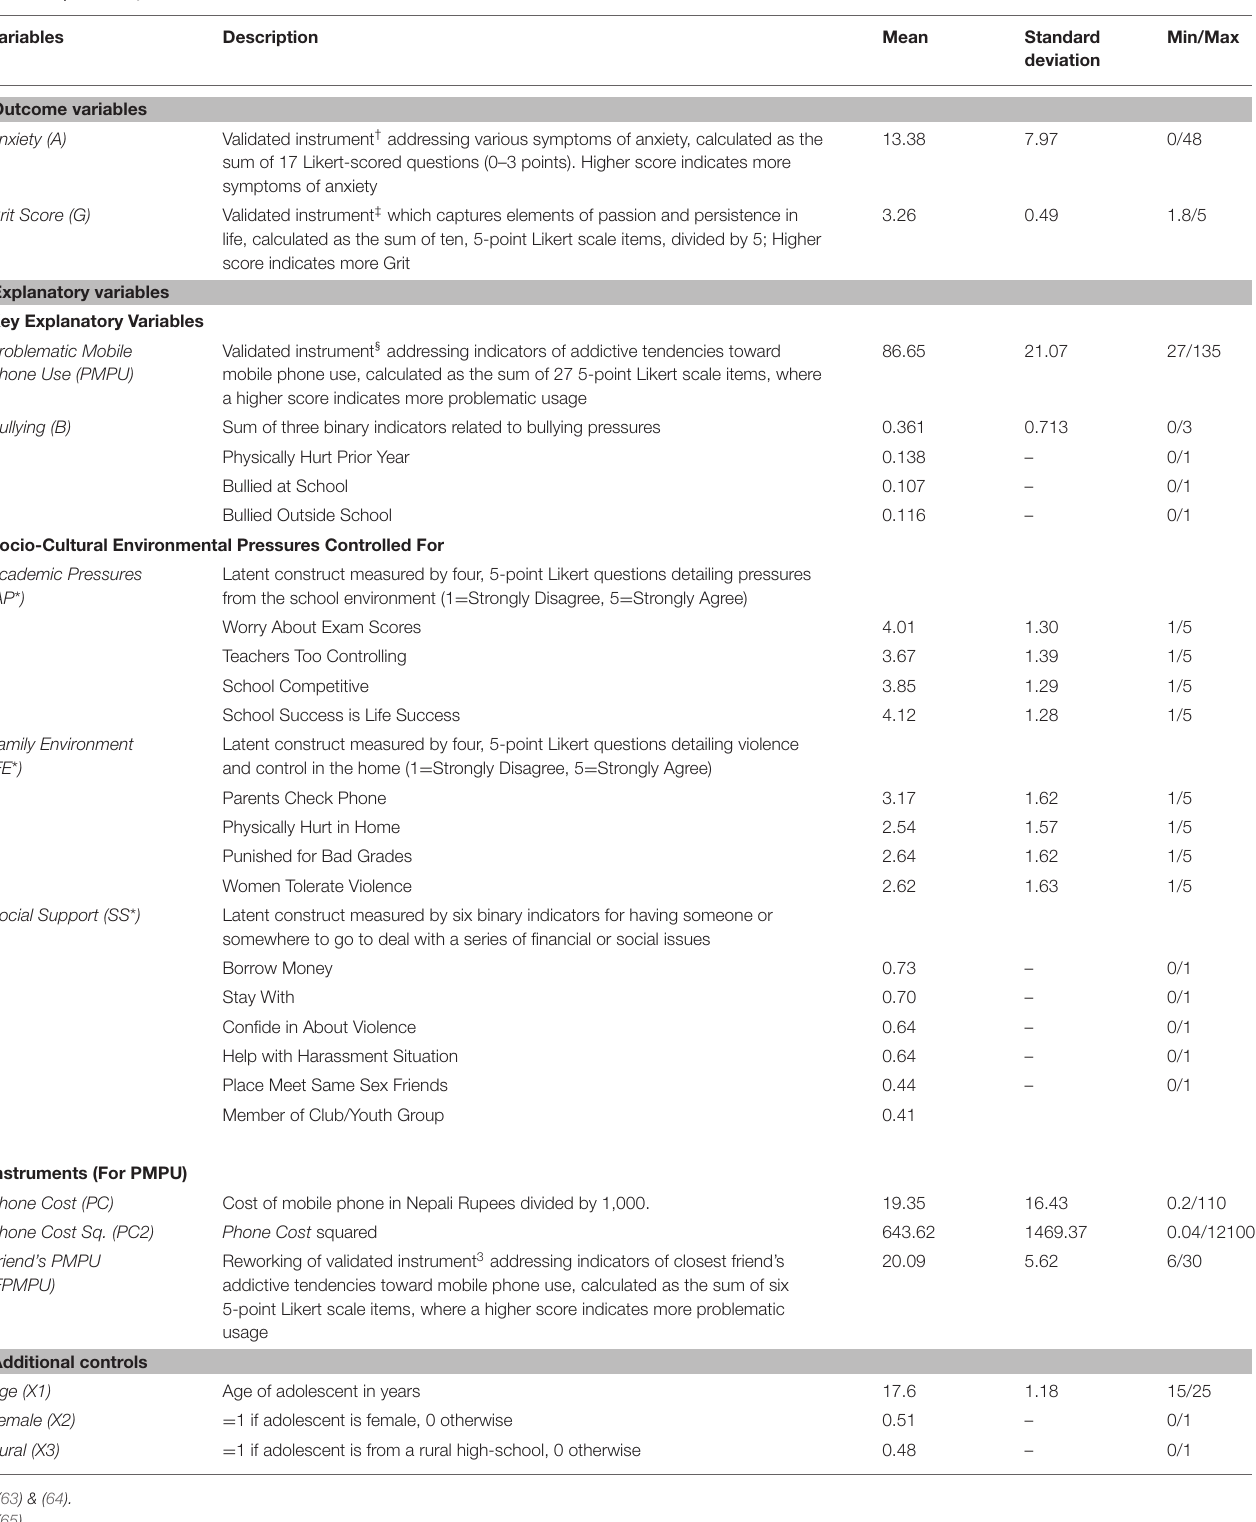
TABLE 1 | Summary statistics of